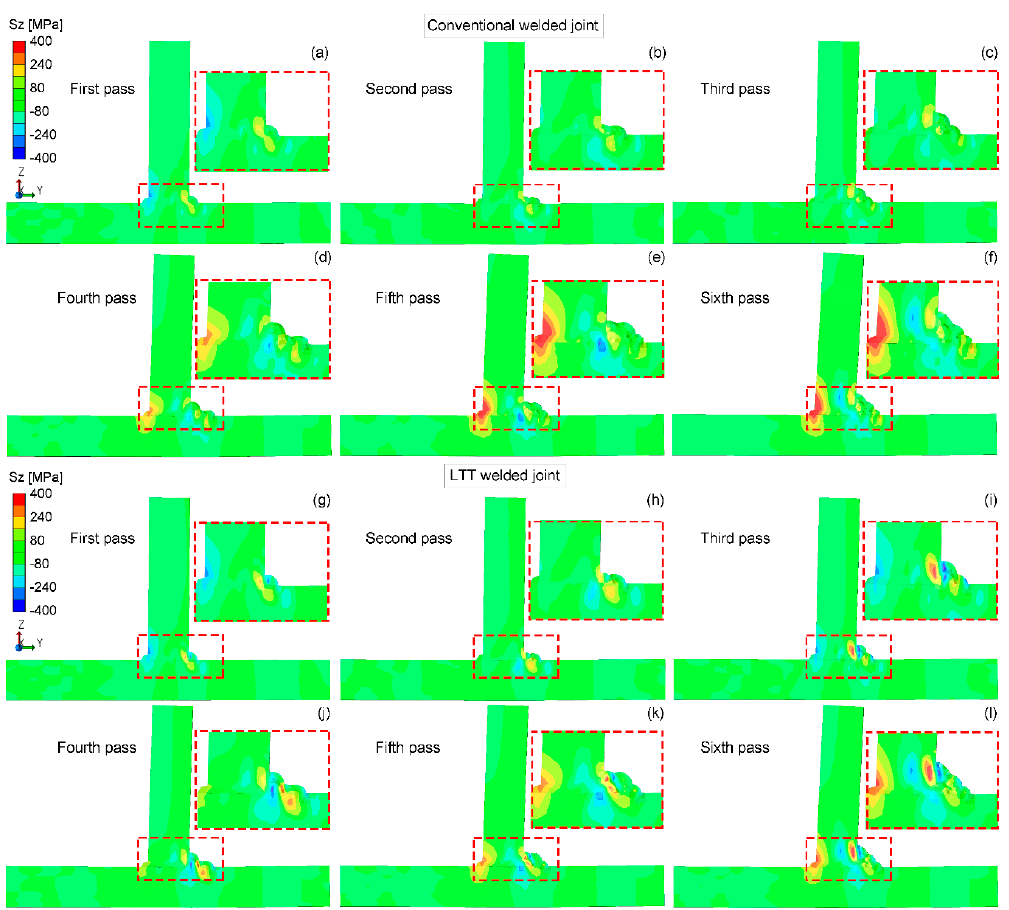
Figure 10. Residual Sz stress distribution in the mid-section of the conventional and LTT welded joints: ( a , g ) first pass; ( b , h ) second pass; ( c , i ) third pass; ( d , j ) fourth pass; ( e , k ) fifth pass; ( f , l ) sixth pass.